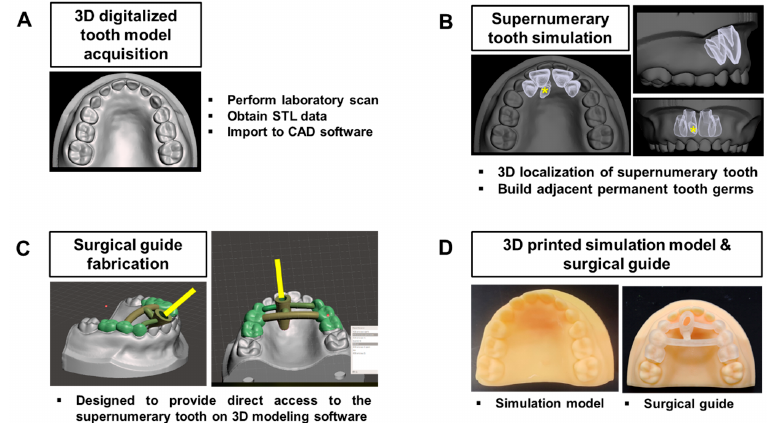
Figure 1. Digital workflow of the development of the 3D printed simulation model and surgical guide for a supernumerary tooth. ( A ) A 3-dimensional digitalized tooth model was obtained by laboratory scan of a primary dentition model. ( B ) A 3D localization of a supernumerary tooth and adjacent permanent tooth germs were determined to imitate the natural positional relationship in the primary dentition. The asterisks refer to the supernumerary tooth. ( C ) A surgical guide was digitally designed to provide direct access to the 3D position of supernumerary tooth. The bars refer to the 3D predetermined path to access the supernumerary tooth. ( D ) A 3D printed simulation model and surgical guide were finally